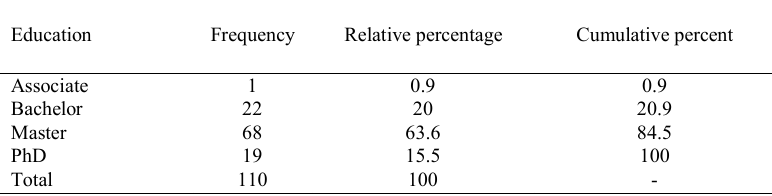
Table 3: Relative distribution of respondents based on